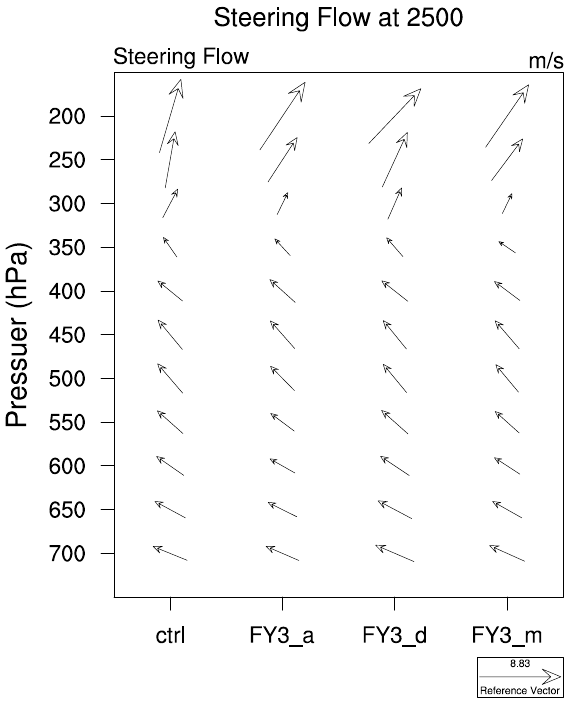
Figure 9. The steering flow from 700 hPa to 200 hPa for four experiments at 0000 UTC 25 July. The mean error of track, central sea level pressure, and maximum surface wind speed of a 54 h forecast from the four simulation experiments are shown in Figure 10, as verified against JMA’s best track data. From Figure 10a, it can be seen that after a 6 h spin-up time, all track error increases from 8 km to almost 100 km with forecast time. The SST replacement with a satellite retrieval product has less effect on the first 12 h forecast. By contrast, CTRL’s track error increases rapider than SST replacing experiments with the largest track error of 100 km. FY3_d with descending SST data creates the lowest track error, except for the 30th forecast at 0006 UTC 24 July. The mean track error of CTRL is 49.2 km, while it is 47.3 km for FY3_a, 45.2 km for FY3_d, and 49.1 km for FY3_m. It is provided that FY-3D SST data benefit from improving the typhoon track forecast. Moreover, compared with CTRL, the largest improvement of the track is at the 54th forecast, with a 50% reduction of